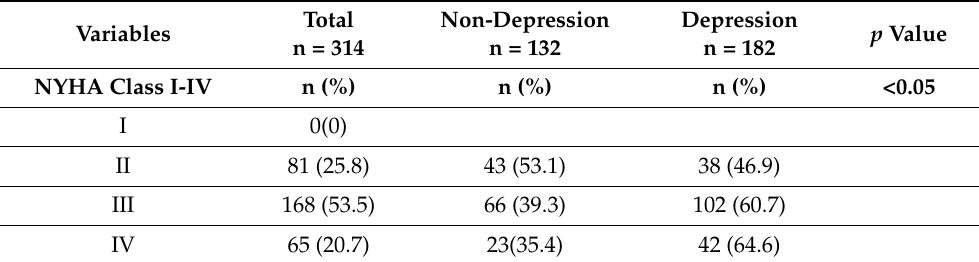
Table 3. Associations of depression with NYHA functional classes.